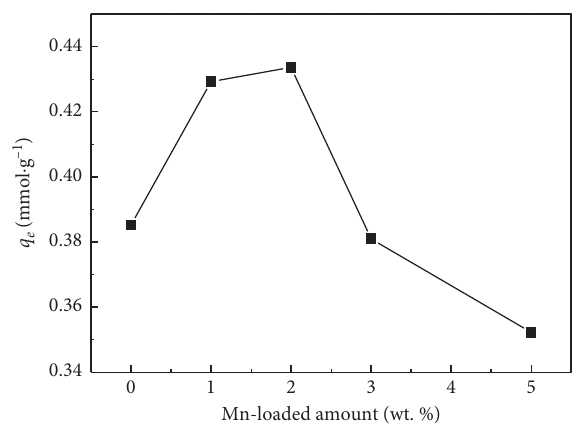
Figure 1: Effects of Mn-loaded amount (model oil: 10mL; DBT, 9.38mmol · L − 1 ; adsorbents, 0.1 g 2wt. % Mn/AC; adsorption temperature, 313K; adsorption time, 4h).